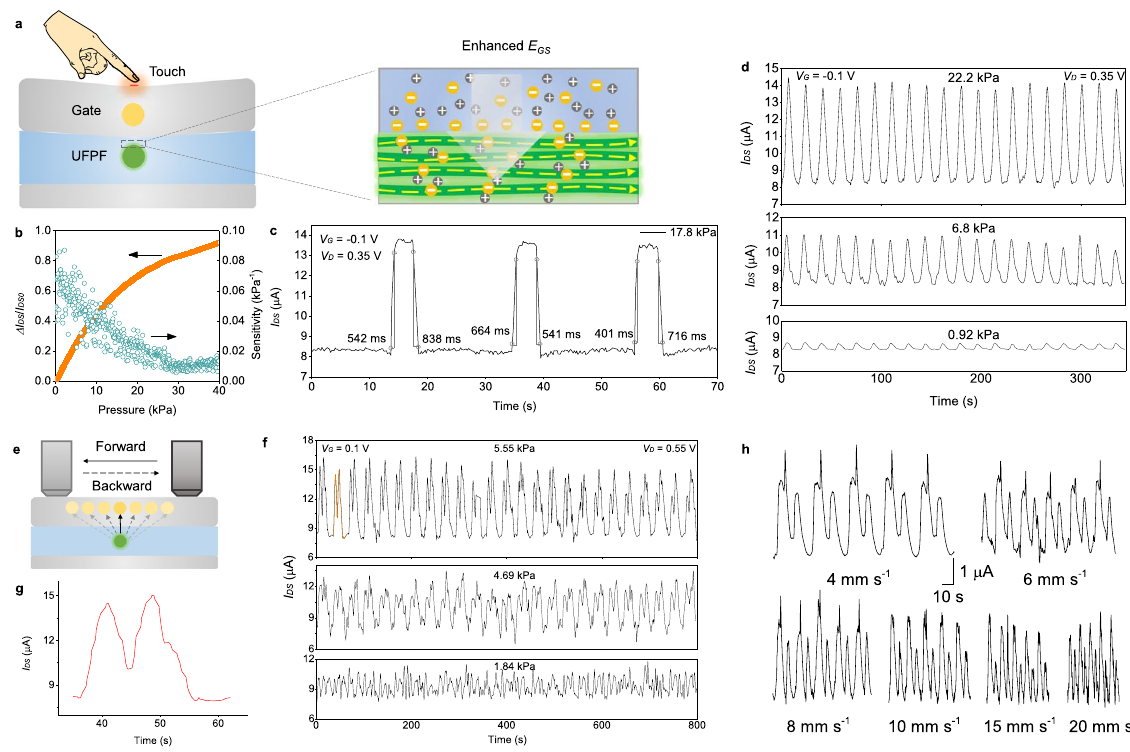
Fig. 5 Electrical response of the all-solid OECT to mechanical deformations. a Schematic of the mechanism explaining the response to the action of external pressure. b Relative drain-source change ( Δ I DS / I DS0 ) and sensitivity as a function of pressure. c Response time of the all-solid OECT when pressing (rising edge) and releasing (falling part) under the instantaneous pressure of 17.8 kPa. d Cyclic response at three different pressure levels (0.92, 6.8, and 22.2 kPa). e , Schematic of the working principle of the response to friction. f Cyclic response at three different frictions (1.84, 4.69, and 5.55 kPa). g An enlarged curve of the marked part in ( f ). h Cyclic response at different friction speeds from 4, 6, 8, 10, 15, to 20 mm s − 1